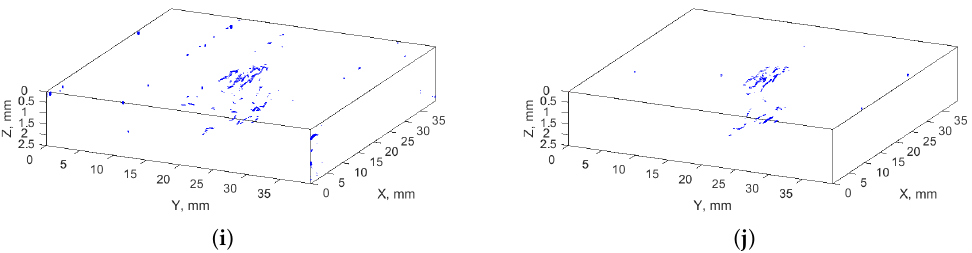
Figure 5. Recognized anomalies—clusters with positive labels nos.: ( a ) 2; ( b ) 4; ( c ) 5; ( d ) 6; ( e ) 7; ( f ) 8; ( g ) 9; ( h ) 10; ( i ) 11; ( j ) 12.